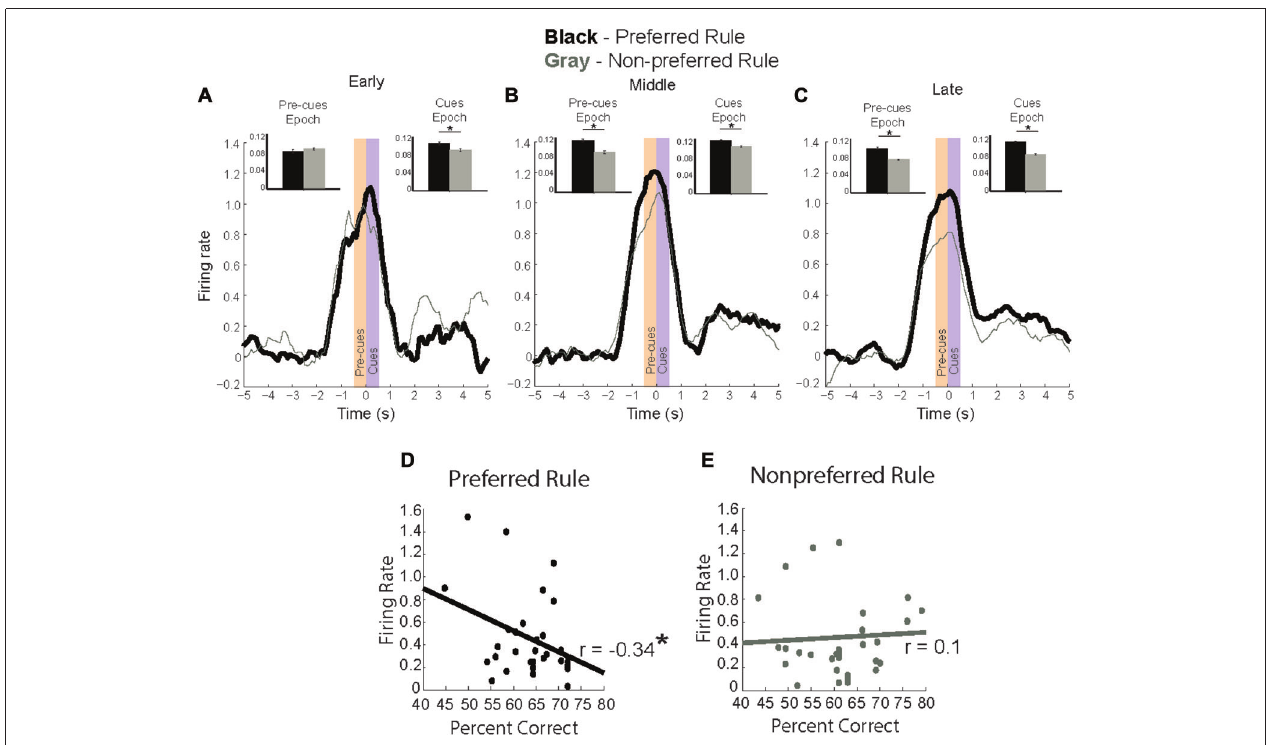
FIGURE 4 | Rule modulated neurons signal rule change. (A–C) baseline subtracted neural activity for preferred (black) and non-preferred (gray) rule blocks with inset bar plots comparing neural firing during pre-cue and cue epochs between rule representations. (A) In first two trials of a rule block, neuronal activity is significantly higher during cue epoch for preferred rule. (B) In the next eight trials, neural activity for preferred rule increases compared to the early trials, and is significantly higher for preferred rule during both the pre-cue epoch and cue epoch. (C) In the last ten trials, neural activity for rules has significantly